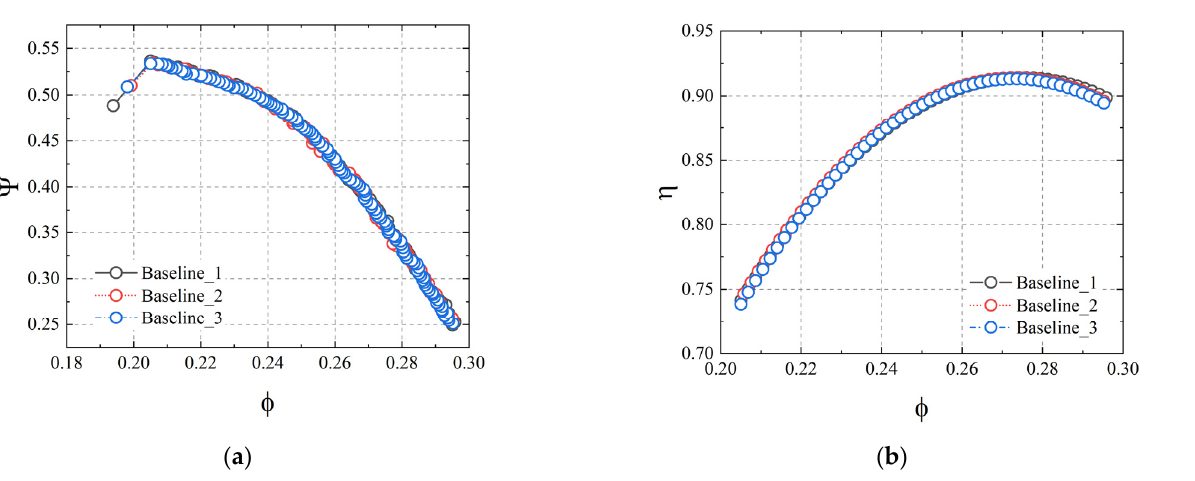
Figure 12. The repeated experiment results of TA36 under baseline condition: ( a ) pressure rise characteristics; and ( b ) efficiency characteristics.